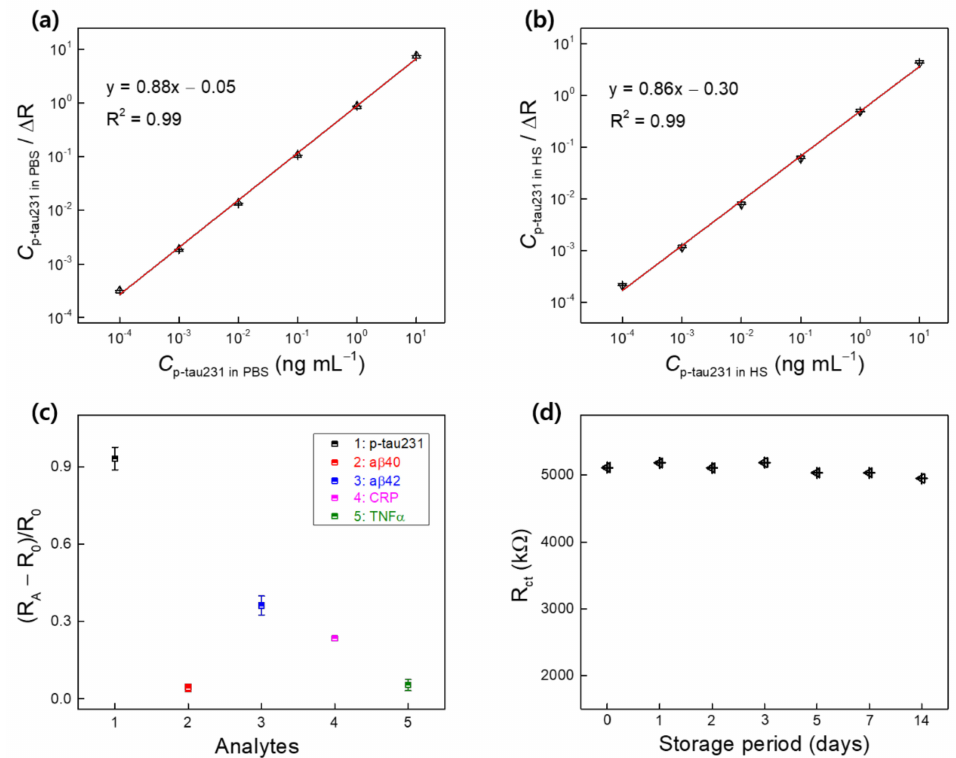
Figure 7. Two linear regressions of C p-tau231 versus C p-tau231 / ∆ R in PBS ( a ) and HS ( b ) were plotted to determine the dissociation constant (K d ); ( c ) selectivity of the biosensor IWE/SAM/EDC-NHS/anti– p-tau231 for the detection of p-tau231 in the attendance of various analytes; ( d ) EIS results of the biosensor were represented by R ct after the storage